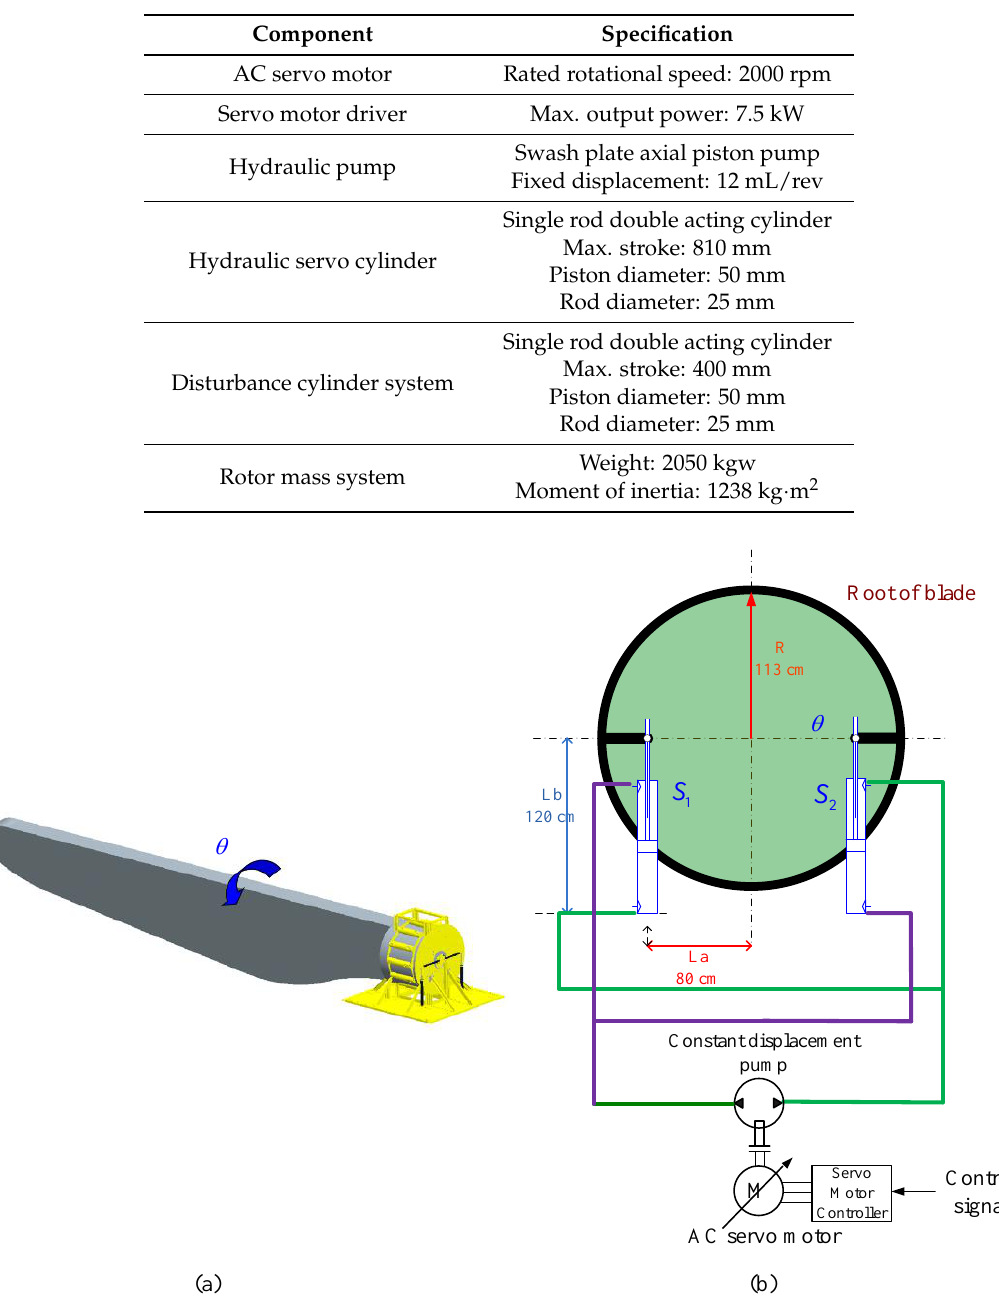
Figure 1. Novel hydraulic pitch control system: ( a ) pitch control by two hydraulic cylinders; ( b ) variable-speed hydraulic pump-controlled system.